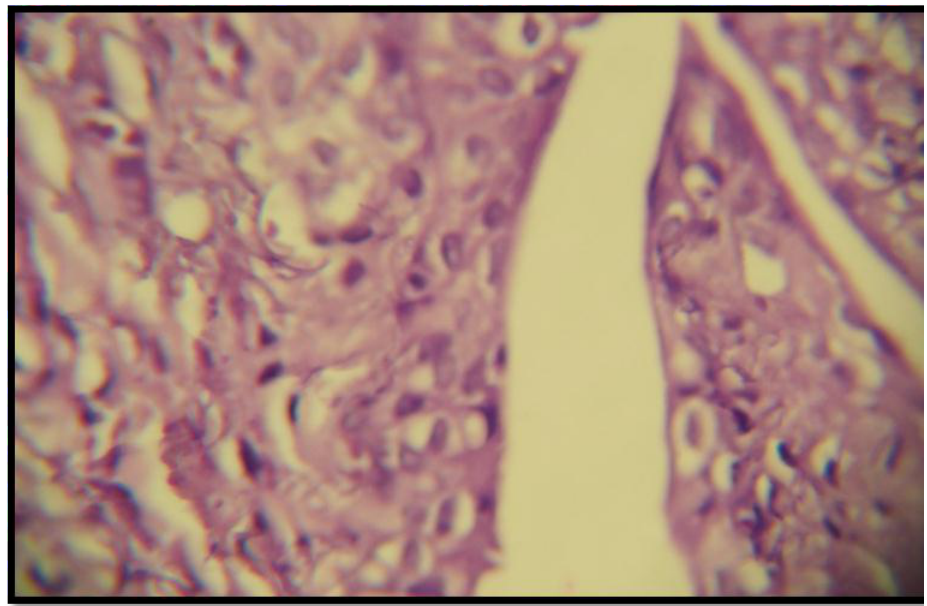
Figure (5): Hisological section in urinary bladder of normal animal showed normal structure of urin bladder (H&E stain